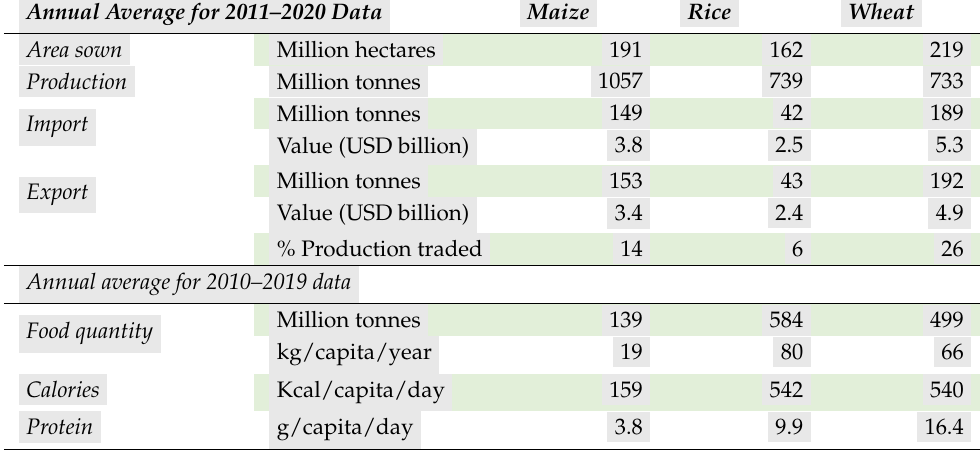
Table 1. Data on cereal production, trade and food supply. Production and trade numbers represent the annual average for the decade 2011 to 2020, and food supply information is the annual average for the decade 2010 to 2019. Maize and wheat imports and exports include grain and flour, and rice imports and exports include broken, husked, milled and paddy rice and rice flour